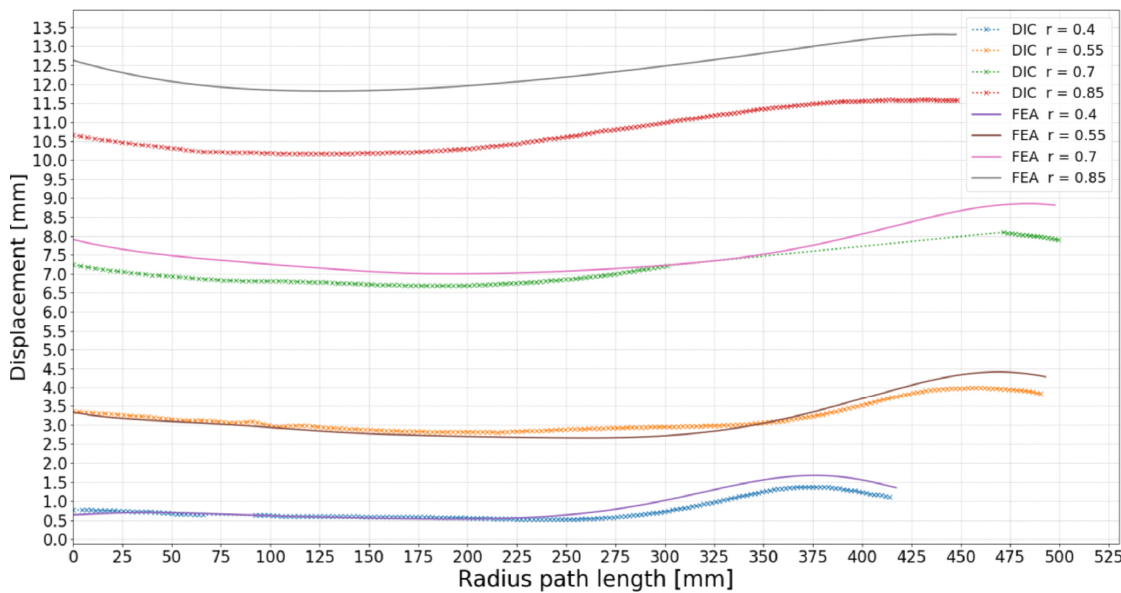
Figure 14. Line plot of the displacement at the lines in Figure 13 for FEA and experiment comparison. The graph starts at the tail point on the left to the nose point on the right. Some data were missing in the DIC measurements due to the DIC not capturing the deformation of the plastic washer used to distribute the load.